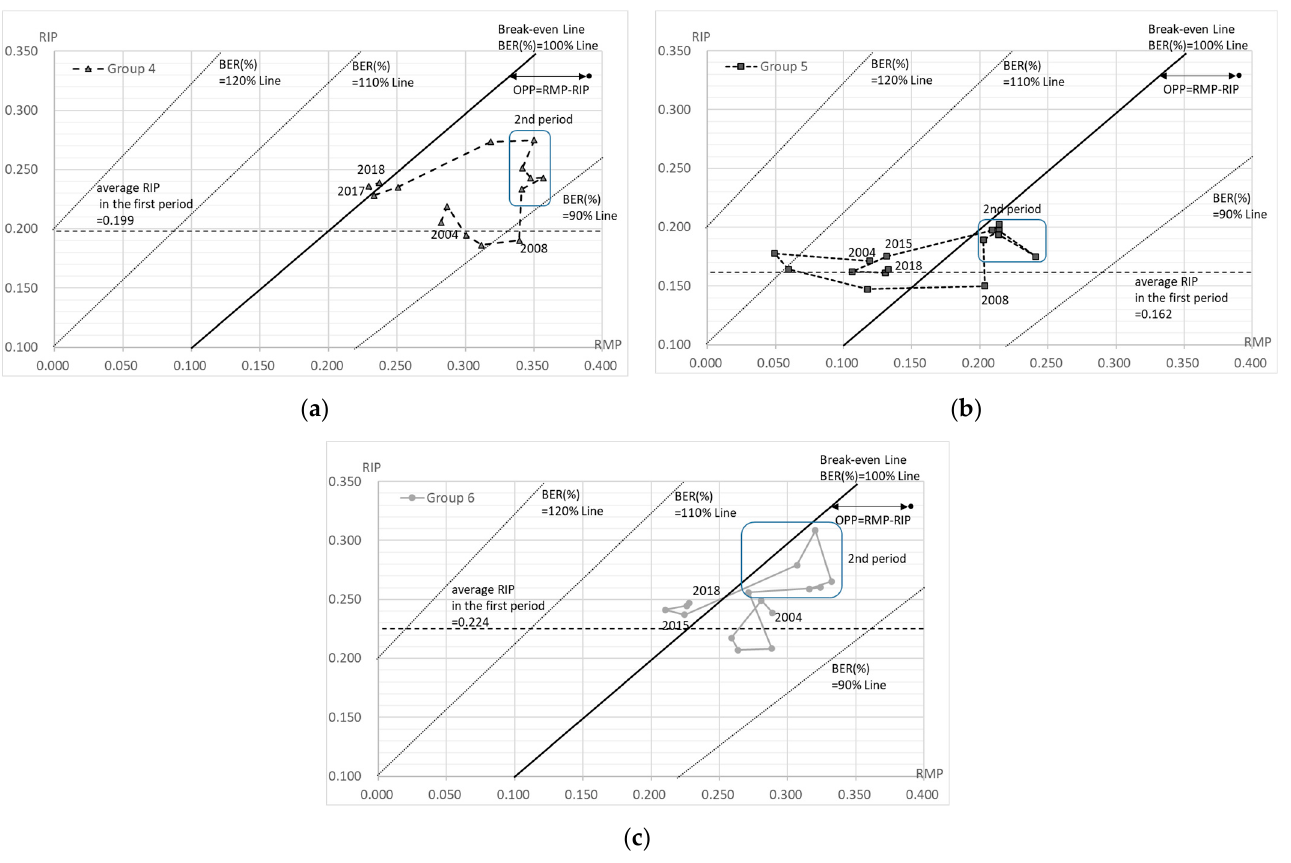
Figure 5. RMP, RIP, OPP, and BER in hospitals offering acute-phase medical care. ( a ) Group 1 (<350 beds); ( b ) group 2 (350–499 beds); ( c ) group 3 (>500 beds). The OPP shows the difference between between RMP and RIP; OPP = RMP − RIP. Break-even Line; RIP = RMP. 90% of break-even ra- RMP and RIP; OPP = RMP ­ RIP. Break-even Line; RIP = RMP. 90% of break-even ratio (BER (%)): tio (BER (%)): RIP = 0.9RMP − 0.1, calculated by RIP = BER (RMP + 1) − 1. 80% of BER (%): RIP = 0.9RMP ­ 0.1, calculated by RIP = BER (RMP + 1) ­ 1. 80% of BER (%): RIP = 0.8RMP ­ 0.20. 110% of BER (%): RIP = 1.1RMP + 0.10.